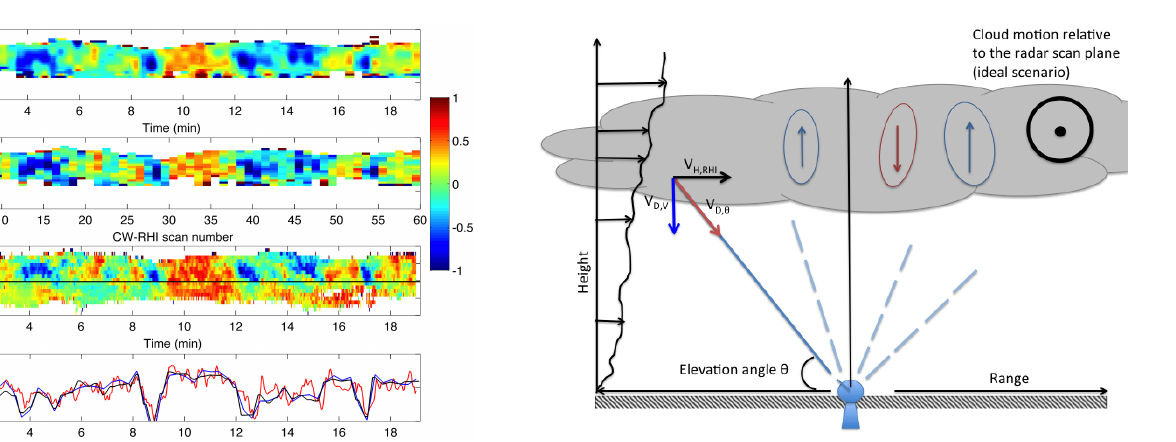
Fig. 9. Time–height radar Doppler velocity field of a stratocumu- lus observed at TCAP with the (a) Ka-SACR gridded ( x = 0m), (b) Ka-SACR post-processed polar coordinates ( θ = 0 ◦ ), and (c) profiling KAZR. The black line indicates the height of panel (d) retrievals. (d) Time series of radar reflectivity from Ka-SACR grid- ded ( x = 0m, black), Ka-SACR post-processed polar coordinates ( θ = 0 ◦ ; blue) and profiling KAZR (red).